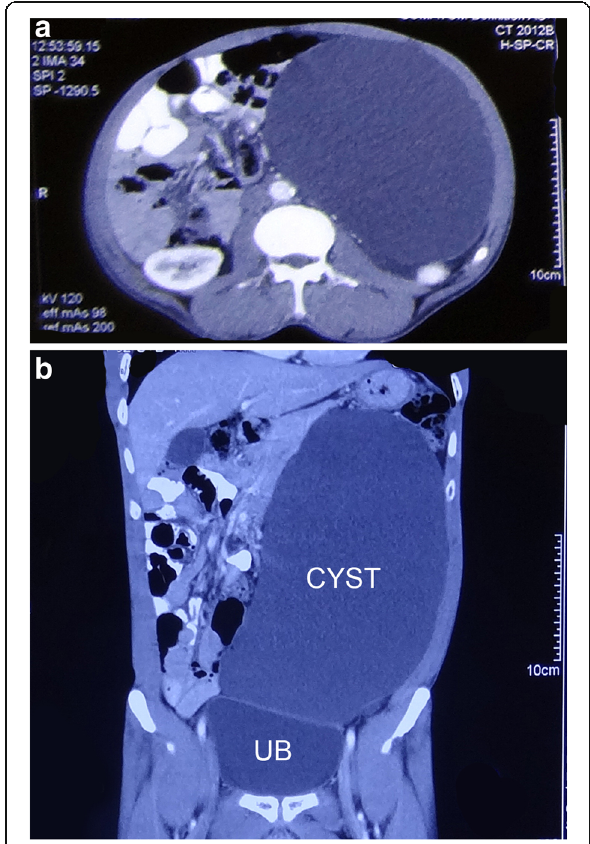
Fig. 2 a Hypodense cystic mass displacing the bowel loops, abdominal aorta, and superior mesenteric vessels to the right side. b Coronal section of CECT showing a cyst occupying almost whole of the abdomen. UB urinary bladder